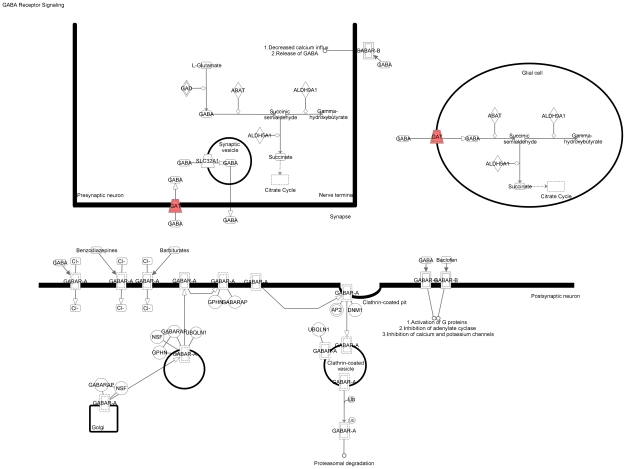
The GABA receptor signaling pathway identified by the Ingenuity software.This is one of the canonical pathways that contains statistically significantly more genes than expected by chance in the group of 114 genes with RPE-specific expression. This figure shows the proteins corresponding to the overrepresented genes. Colored symbols indicate their presence among the 114 genes with RPE-specific expression, uncolored genes are added by the software to form pathways. Solid lines between molecules indicate direct physical relationships between molecules (such as regulating and interacting protein domains); dotted lines indicate indirect functional relationships (such as co-regulation of expression of both genes in cell lines).